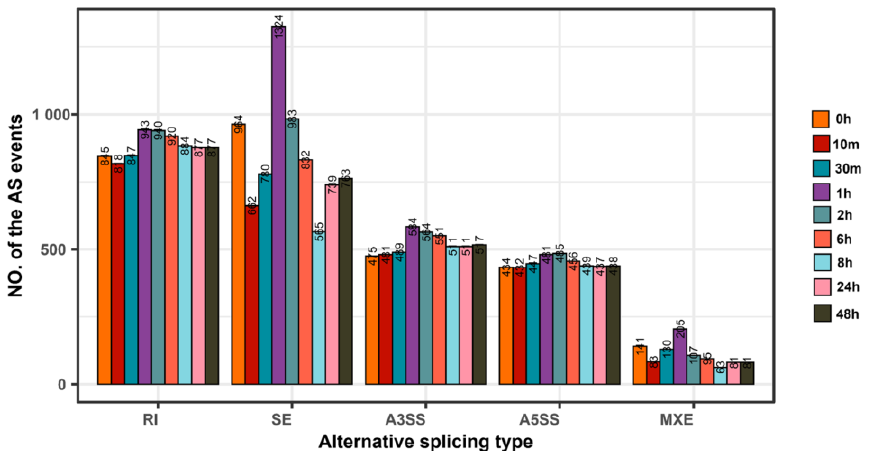
Figure 2. Statistics of the number of AS events in samples at different time points. RI was the most frequent, followed by SE, A3SS, A5SS, and MXE.